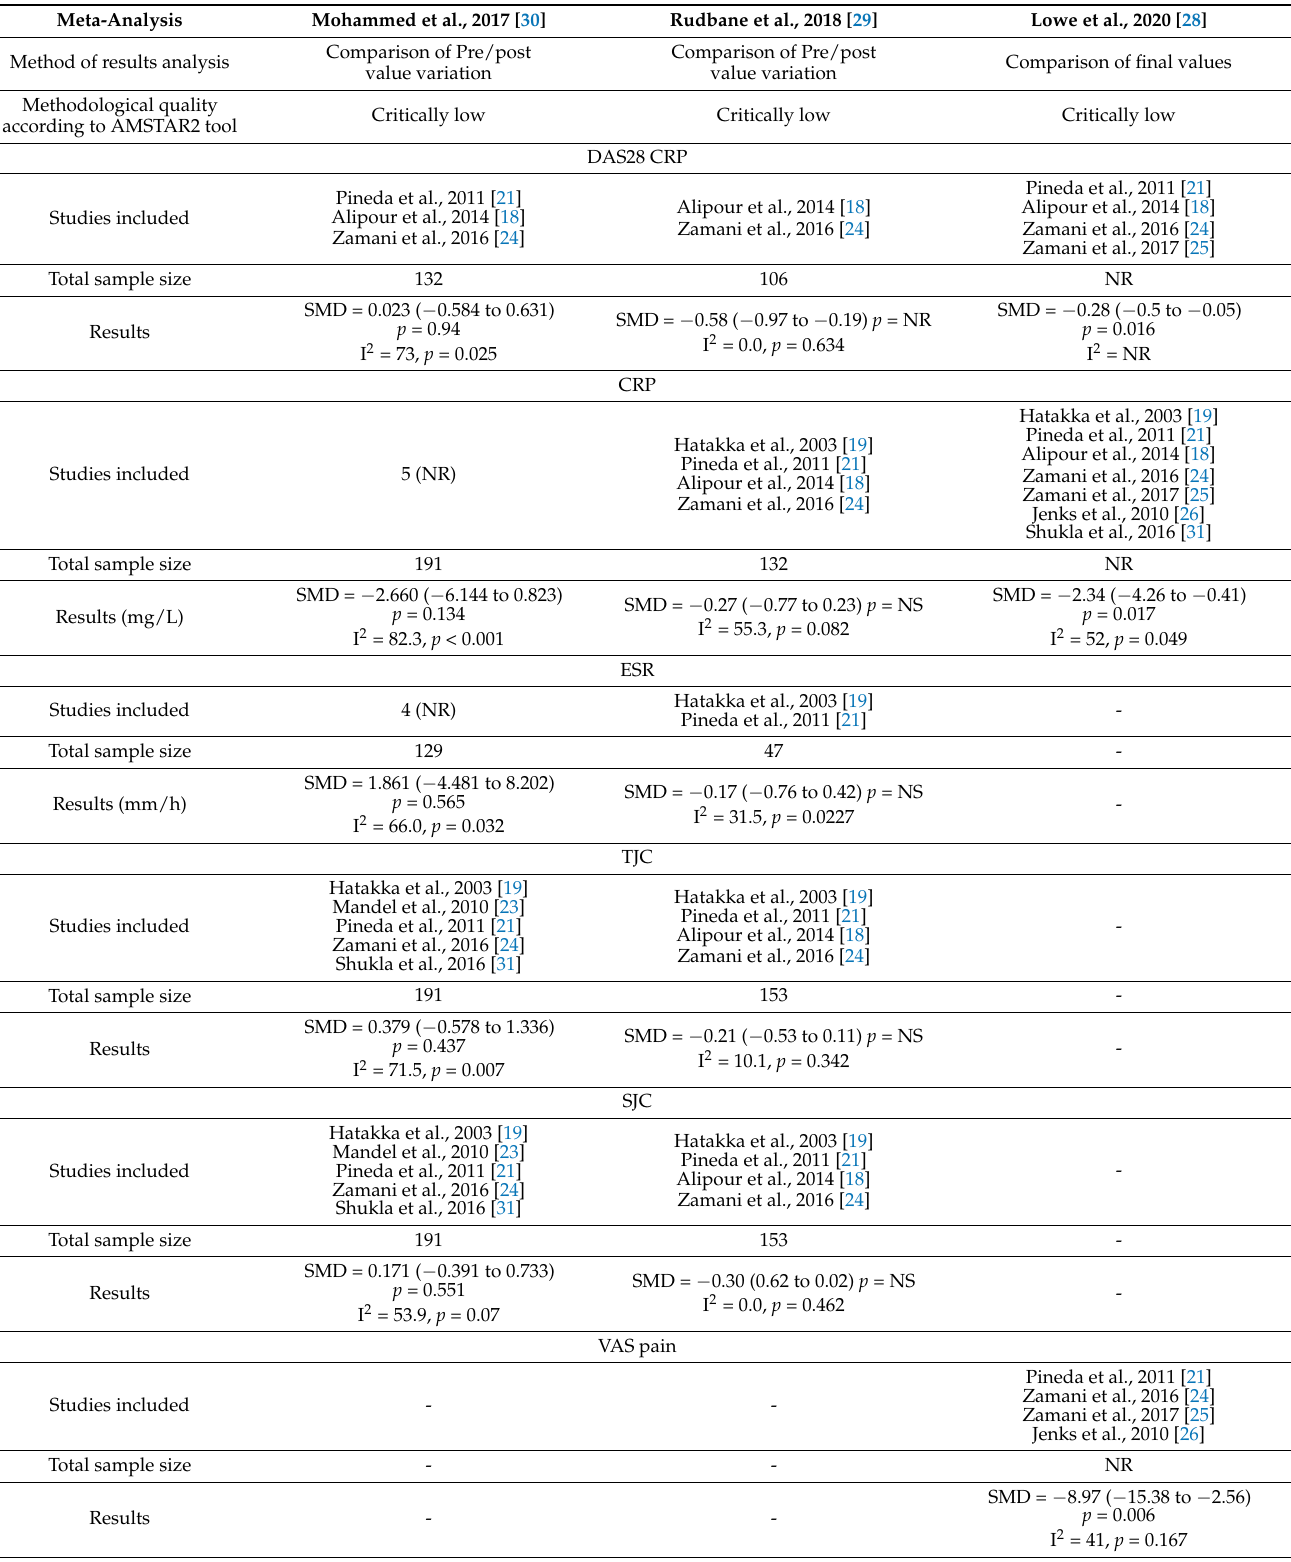
Table 4. Meta-analysis available in rheumatoid arthritis and